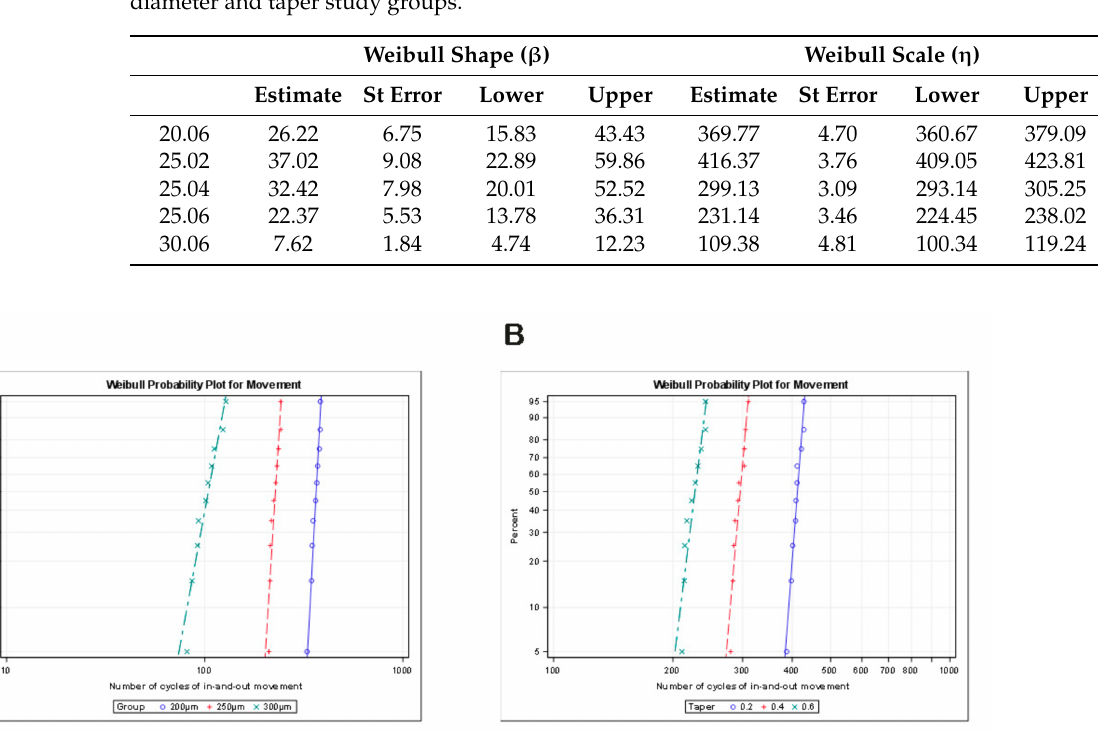
Figure 10. Weibull probability plots of the number of cycles of in-and-out movements for the ( A ) apical diameter and ( B ) taper study